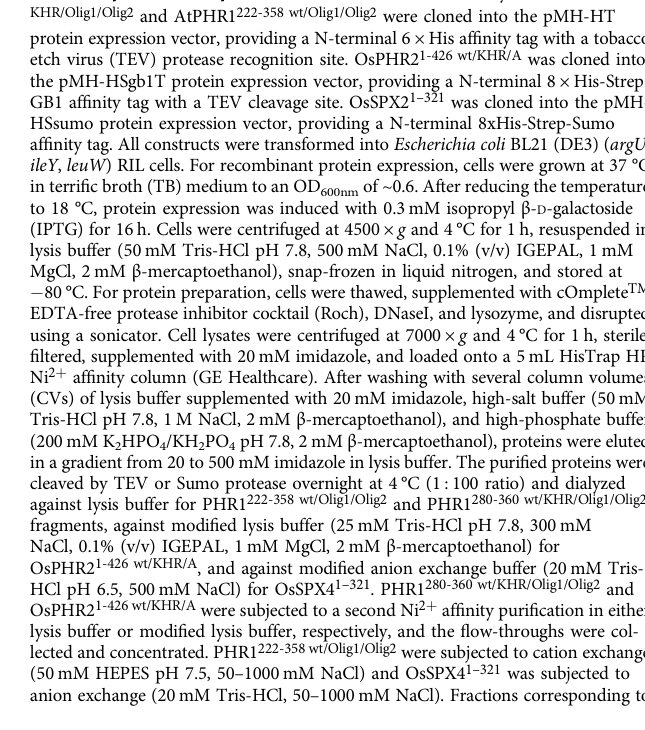
Fig. 4 Mutation of the AtPHR1 KHR motif impairs interaction with AtSPX1 and Pi homeostasis in planta. a Growth phenotypes of Col-0 wild type, phr1-3 of phr1-3 complementation lines expressing FLAG-AtPHR1, FLAG-AtPHR1 K325A , FLAG-AtPHR1 H328A , FLAG-AtPHR1 R335A , FLAG-AtPHR1 K325A R335A , and FLAG-AtPHR1 K325A H328A R335A under the control of the AtPHR1 promoter at 21 DAG grown in Pi-suf fi cient conditions. One representative line per complementation construct is shown (speci fi ed by a #), additional lines are shown in Supplementary Fig. 4. b Plot representing the cellular Pi content of the lines shown in a . Bold black line, median; box, interquartile range (IQR); whiskers, lowest/highest data point within 1.5 IQR of the lower/upper quartile. Seedlings were germinated and grown on vertical 1/2 MS plates for 8 days, transferred to 1/2 MS plates supplemented with either 0, 1, or 10 mM Pi and grown for additional 7 days. For each line, four plants were measured in technical duplicates. Pi contents of all lines can be found in Supplementary Fig. 4 (* p < 0.05; ** p < 0.01; *** p < 0.001). c Heat maps of PSI marker gene ( ACP5 , IPS1 , MGD3 , PECP1 , PPsPase , SPX1 ) expression analyses of the lines shown in a , represented as Z -scores. For each line, three biological replicates were analyzed in technical triplicates by qRT-PCR. d Co-immunoprecipitation (Co-IP) experiment assessing the ability for immobilized GFP-AtPHR1 and GFP-AtPHR1 KHR/A to interact with mCherry-AtSPX1 in N. benthamiana . Input western blottings are shown alongside. Experiment was performed twice with similar results. e Genetic interactions in the VIH-PHR signaling pathway. Col-0